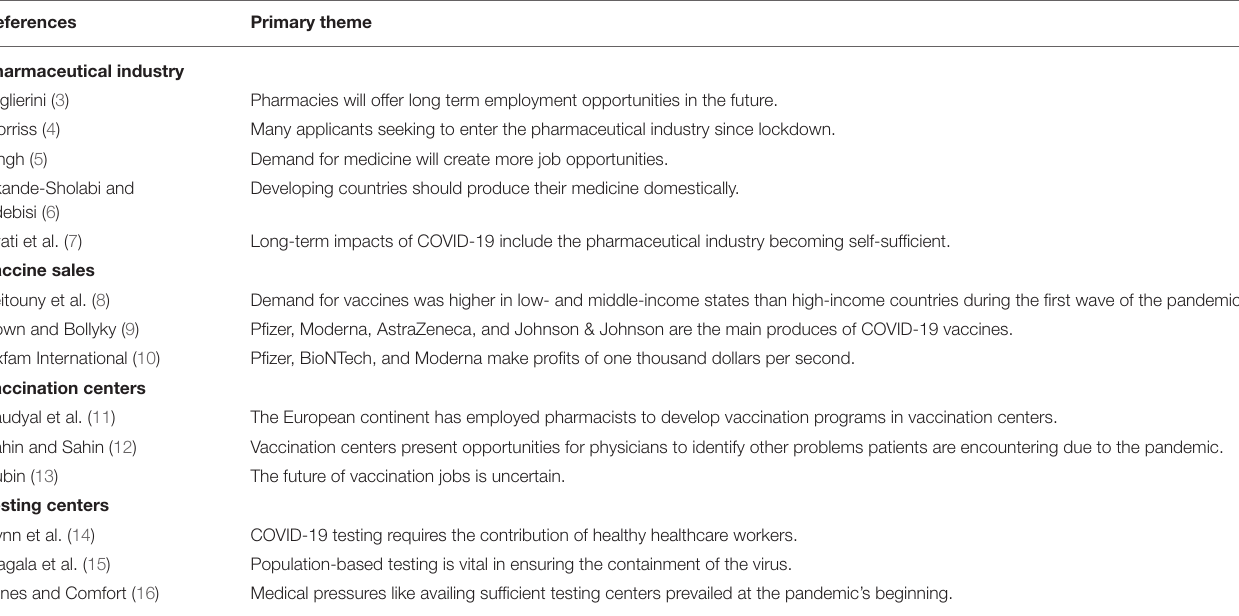
TABLE 1 | Main themes of included